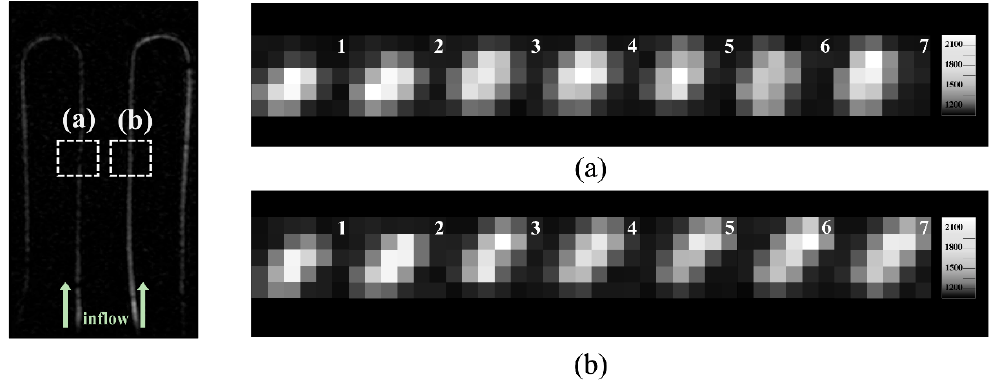
Figure 3. Comparison of signal-to-noise ratios (SNR) according to the magnetic resonance angi- ography sequences. A coronal maximum intensity projection (MIP) image in the 1.0 mm tube diam- eter is provided for reference (left). ( a ) Axial MIP image of the selected regions of interest. ( b ) SNR graph of each sequence. Note that these data are representative of 1.0 mm tube diameter. Abbrevi-